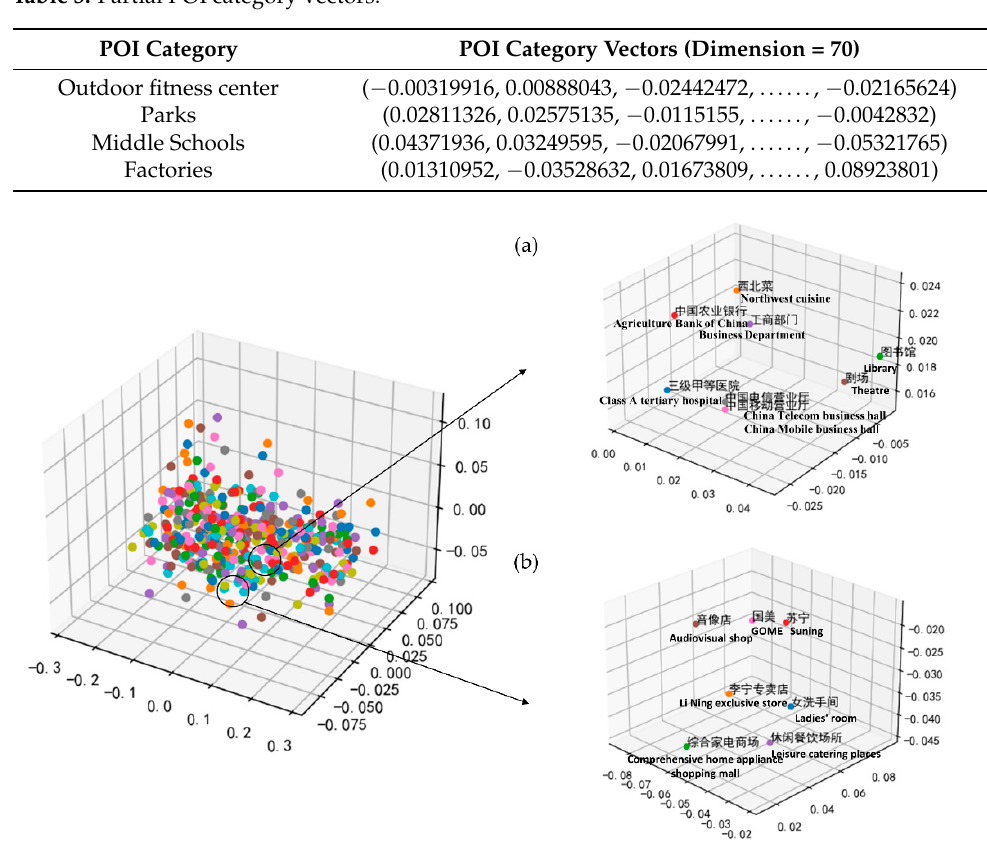
Figure 7. The POI type vectors is visualized in the three ‐ dimensional coordinate system, and its part is taken for enlarged display, as shown in ( a , b ). Note: Because the training is carried out with Chinese labels, it is displayed in Chinese. And a English definition below each label.